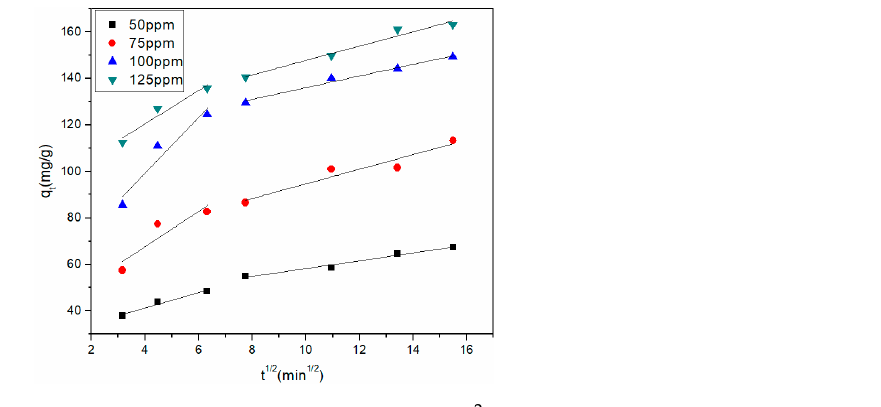
Figure 7. Intraparticle diffusion model of Cu 2+ adsorption by the rGO membrane.